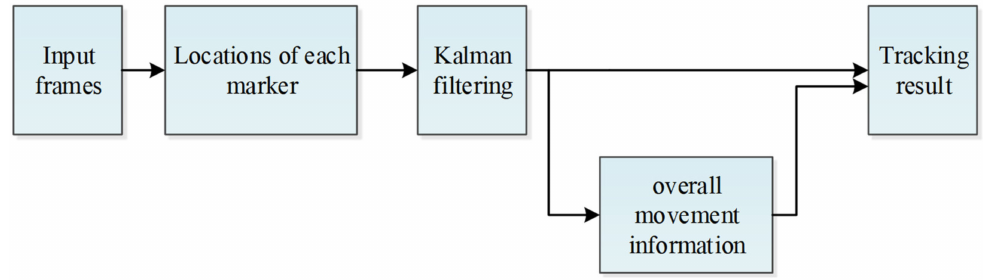
Figure 8. Kalman filter based on overall information of